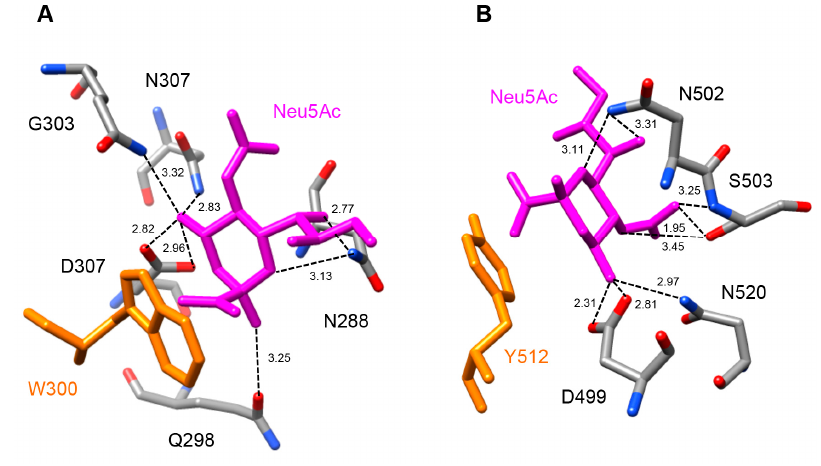
Figure 5. Docking of Neu5Ac to the carbohydrate-binding sites of Md2RIP. ( A ) Network of hydrogen bonds (dashed lines) anchoring Neu5Ac to the carbohydrate-binding site of subdomain 1 α of Md2RIP. H-bond distances are expressed in angström (Å). The W300 aromatic residue (colored orange) participates in a stacking interaction with the pyranose ring of Neu5Ac; ( B ) Network of hydrogen bonds (dashed lines) anchoring Neu5Ac to the carbohydrate-binding site of subdomain 1 γ of Md2RIP. The Y512 aromatic residue (colored orange) participates in a stacking interaction with the pyranose ring of Neu5Ac.